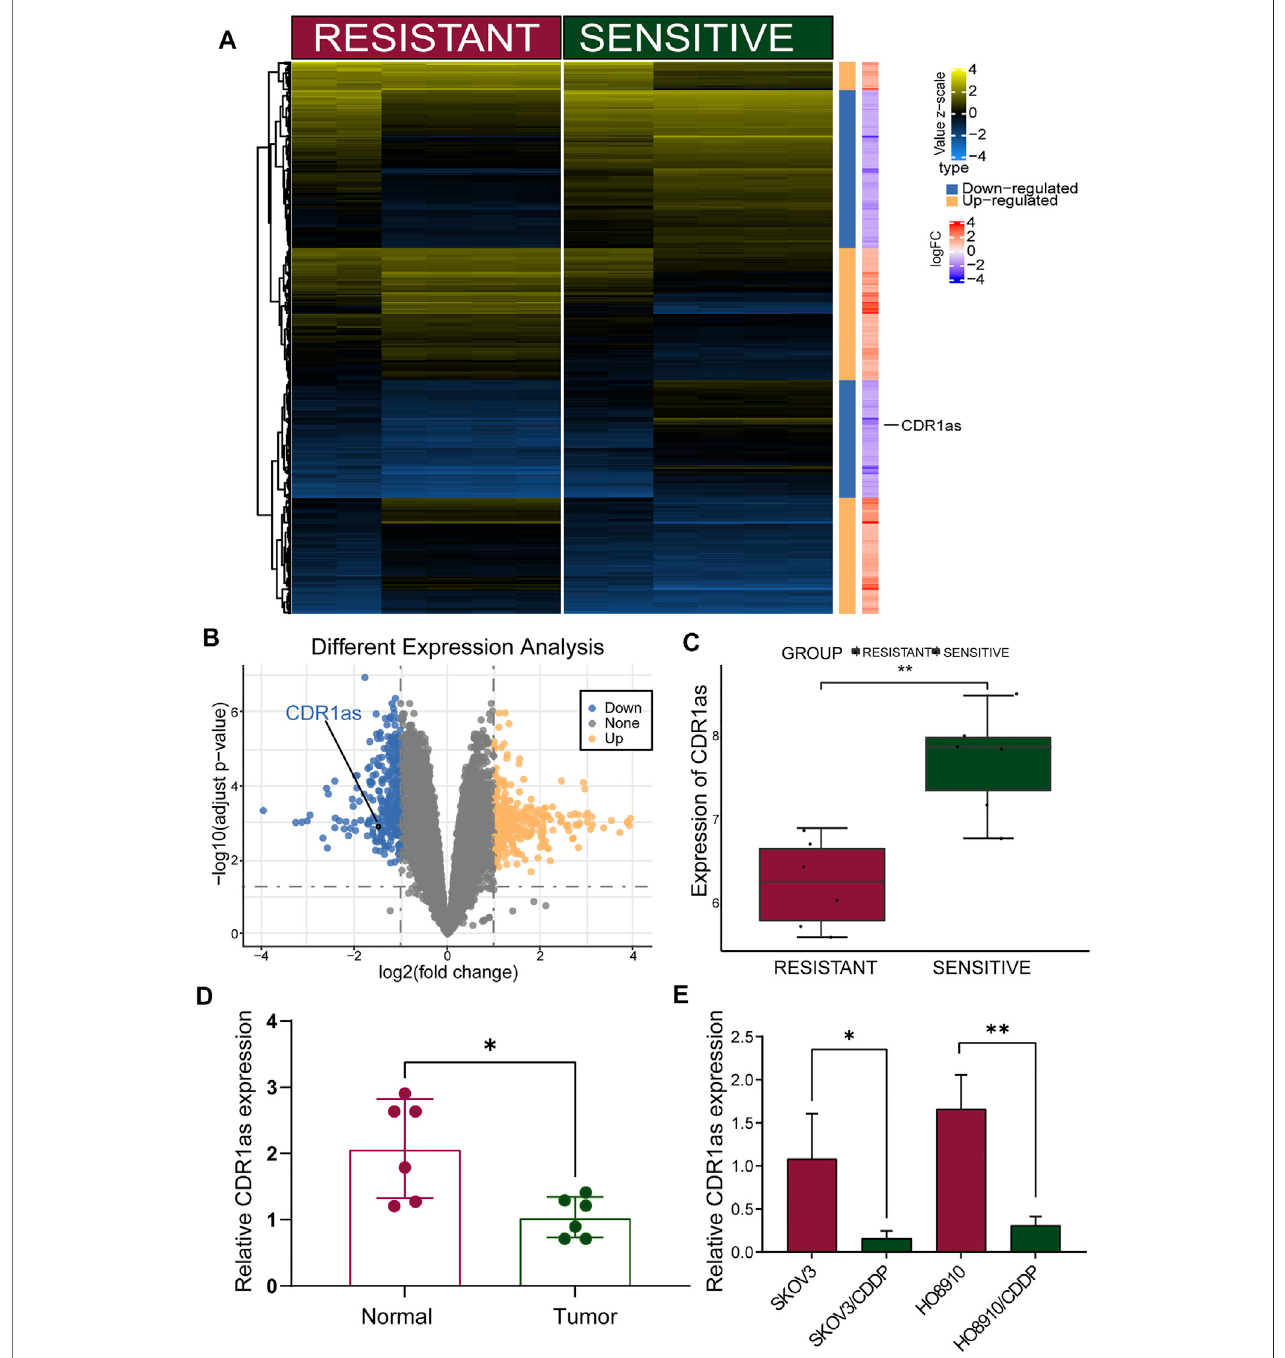
FIGURE1 | Circular RNACDR1assigni fi cantdownregulatedin OCresistanttissues and cell lines. (A,B) The heatmap and volcanoplot show variation in circRNAs expressionbetweenCDDP-resistantand-sensitiveOCcelllines. (C) TheexpressionofCDR1asinCDDP-resistantand-sensitivecelllinesbybioinformaticsanalysis. (D) ExpressionlevelsofCDR1asinOCtissuesandtheiradjacent normaltissuesbyqRT-PCR. (E) qRT-PCRofCDR1asexpression inCDDPresistantOCcelllines(SKOV3/ CDDP and HO8910/CDDP) and the parental cell lines (SKOV3 and HO8910). Theseresults were presented asthemean ± SDs. * p < 0.05, ** p < 0.01, *** p < 0.001 and **** p <